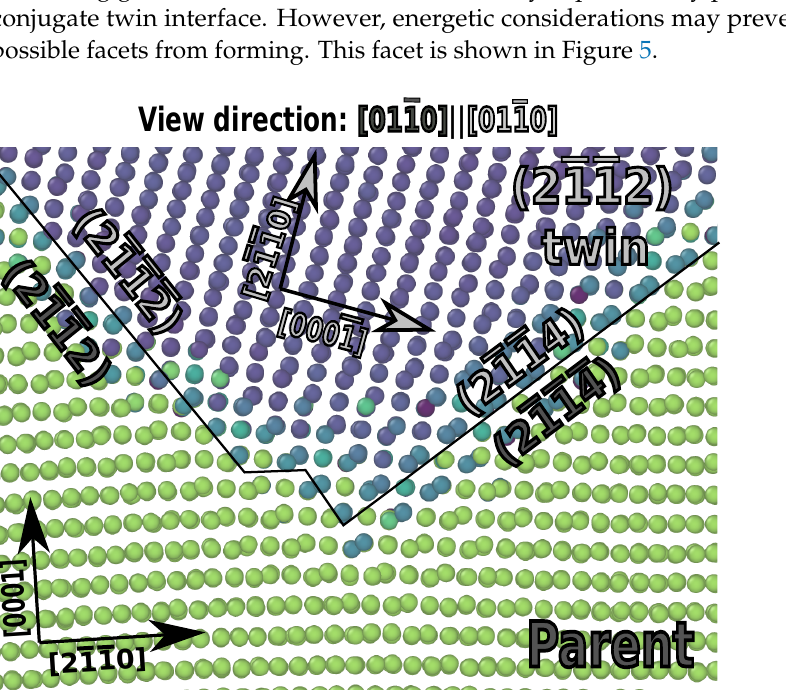
Figure 5. ( 2112 ) facet producing ( 2114 ) twin interface. The facet disclination is large, thereby, producing evident distortion of the parent lattice orientation. The interface produced by the MEAM/spline potential for the ( 2112 ) and ( 2114 ) interfaces sometimes showed significant distor- tion during twin-growth reminiscent of the α to ω phase